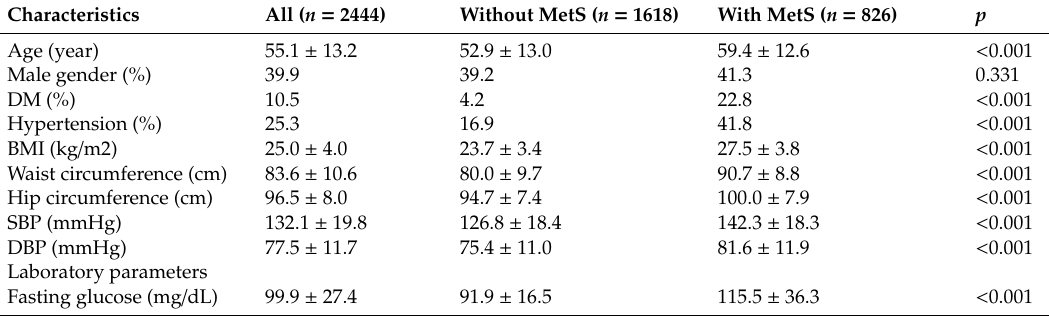
Table 1. Comparison of clinical characteristics among participants, with and without